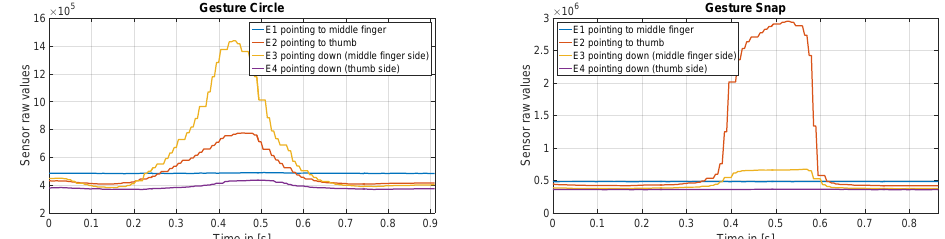
Figure 10. Finger gesture set used for evaluation.